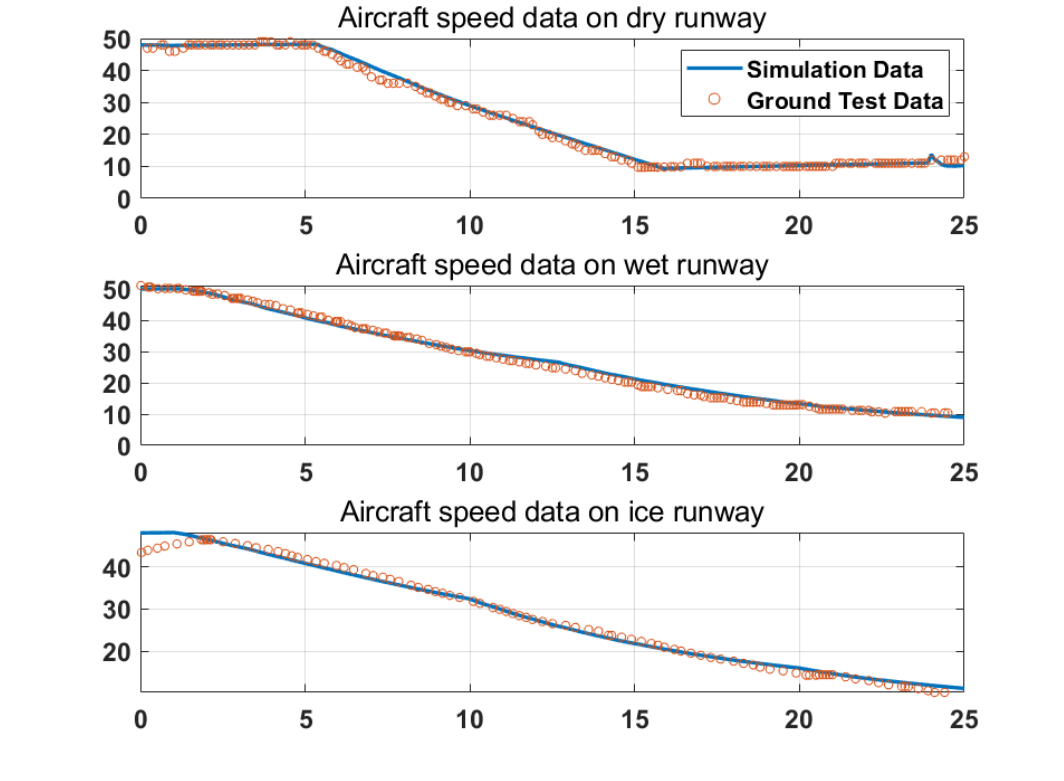
Figure 13. Comparison of ground test aircraft speed data and simulation aircraft speed